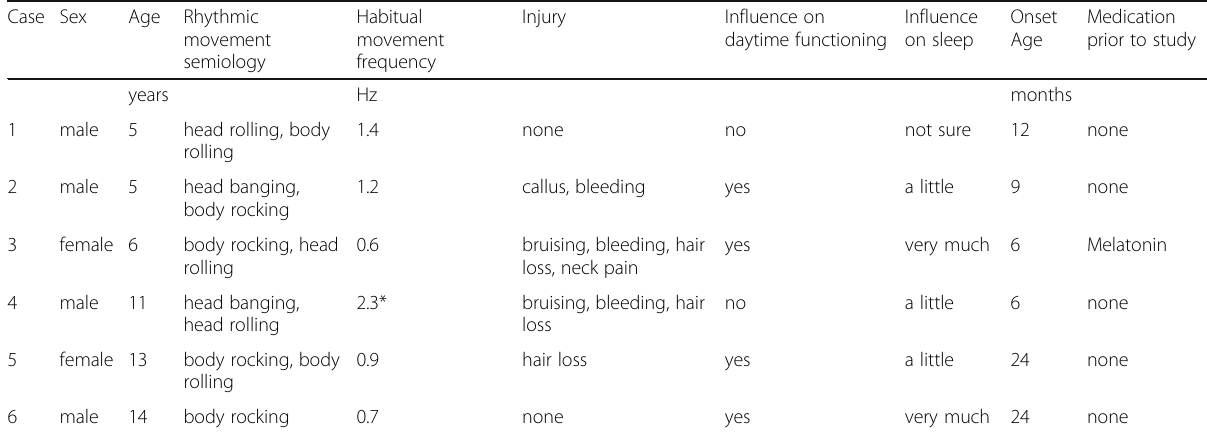
Case Sex Age Rhythmic